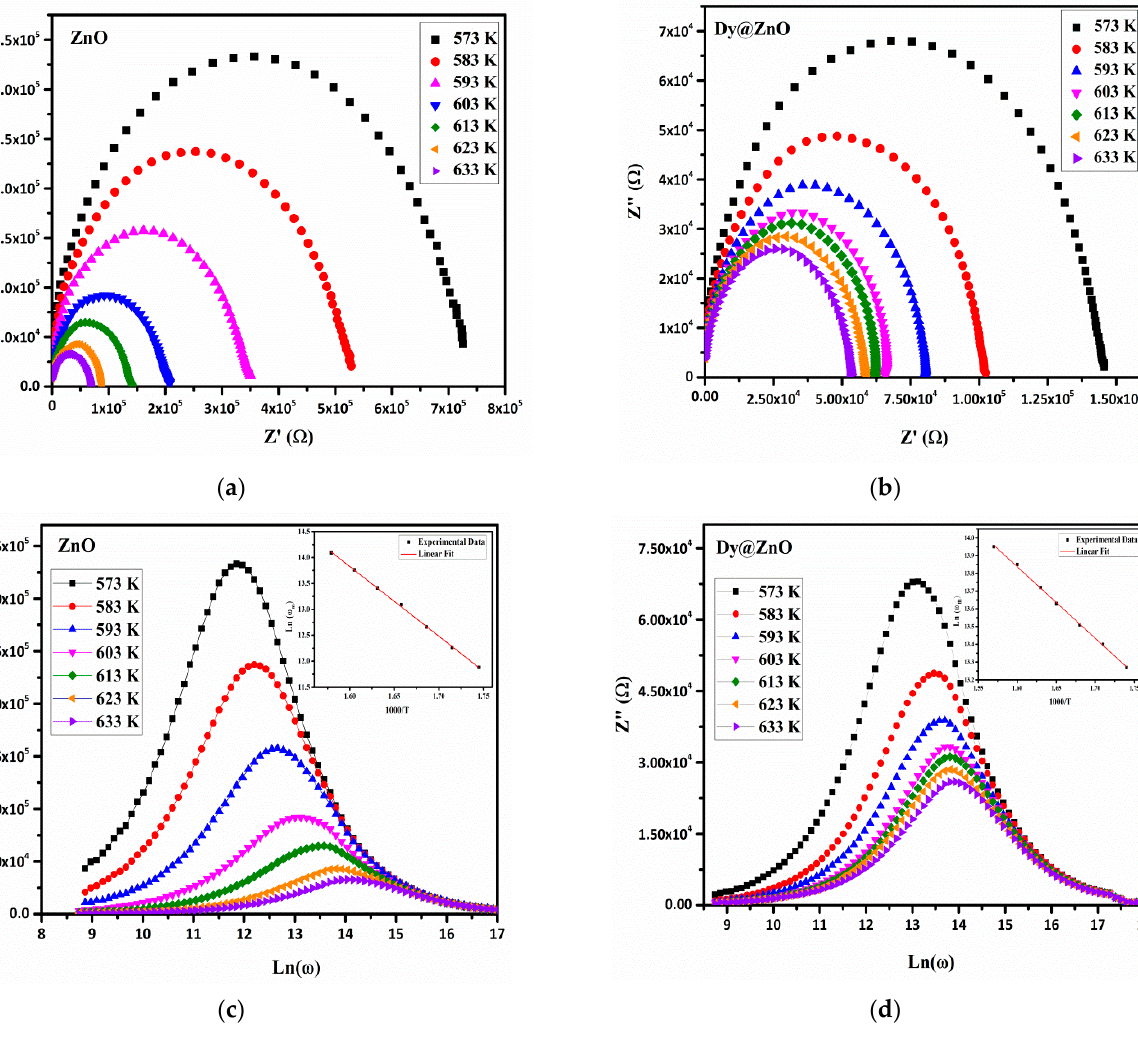
Figure 5 . Complex impedance spectra at different temperatures for the pure ( a ) and Dy-doped ZnO ( b ) thin films. Angular frequency dependence of Z” at different temperatures for the pure ( c ) and Dy-doped ZnO ( d ) thin films.